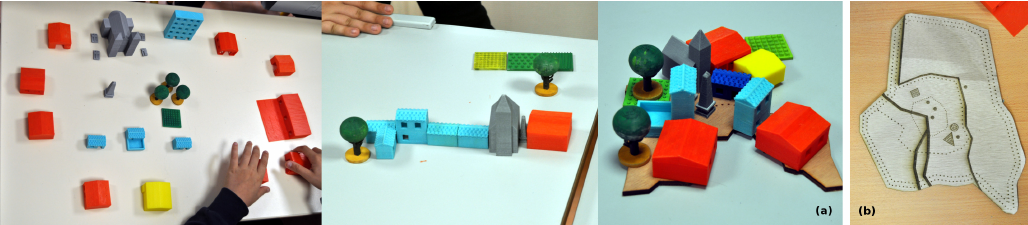
Figure 5. ( a ) non-interactive models that children reconstructed using tangibles only. From left to right, a major city (C3–C1), a village (C4–C5), and a small city (C1); ( b ) laser cut wood representation of the shape of each city, which can be used with the